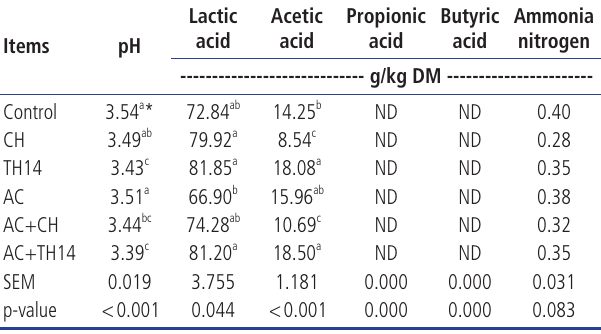
Table 3. Fermentation quality of sorghum silages at 30 days after fermentation Lactic Items pH